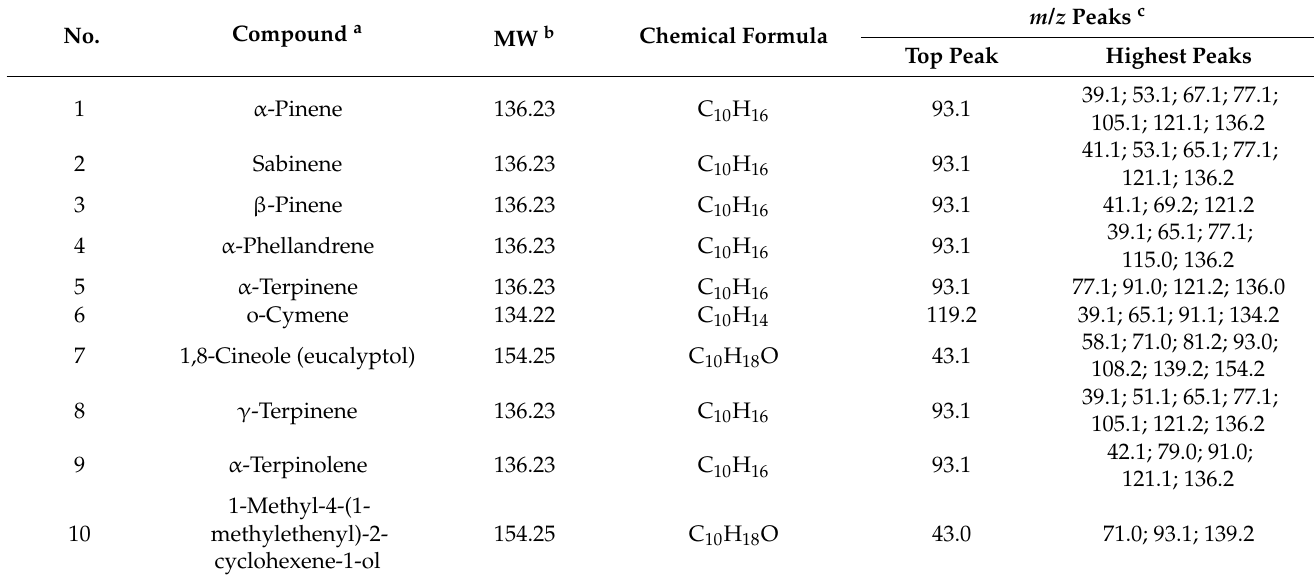
Table 3. The identification of compounds in the plant-based substance via